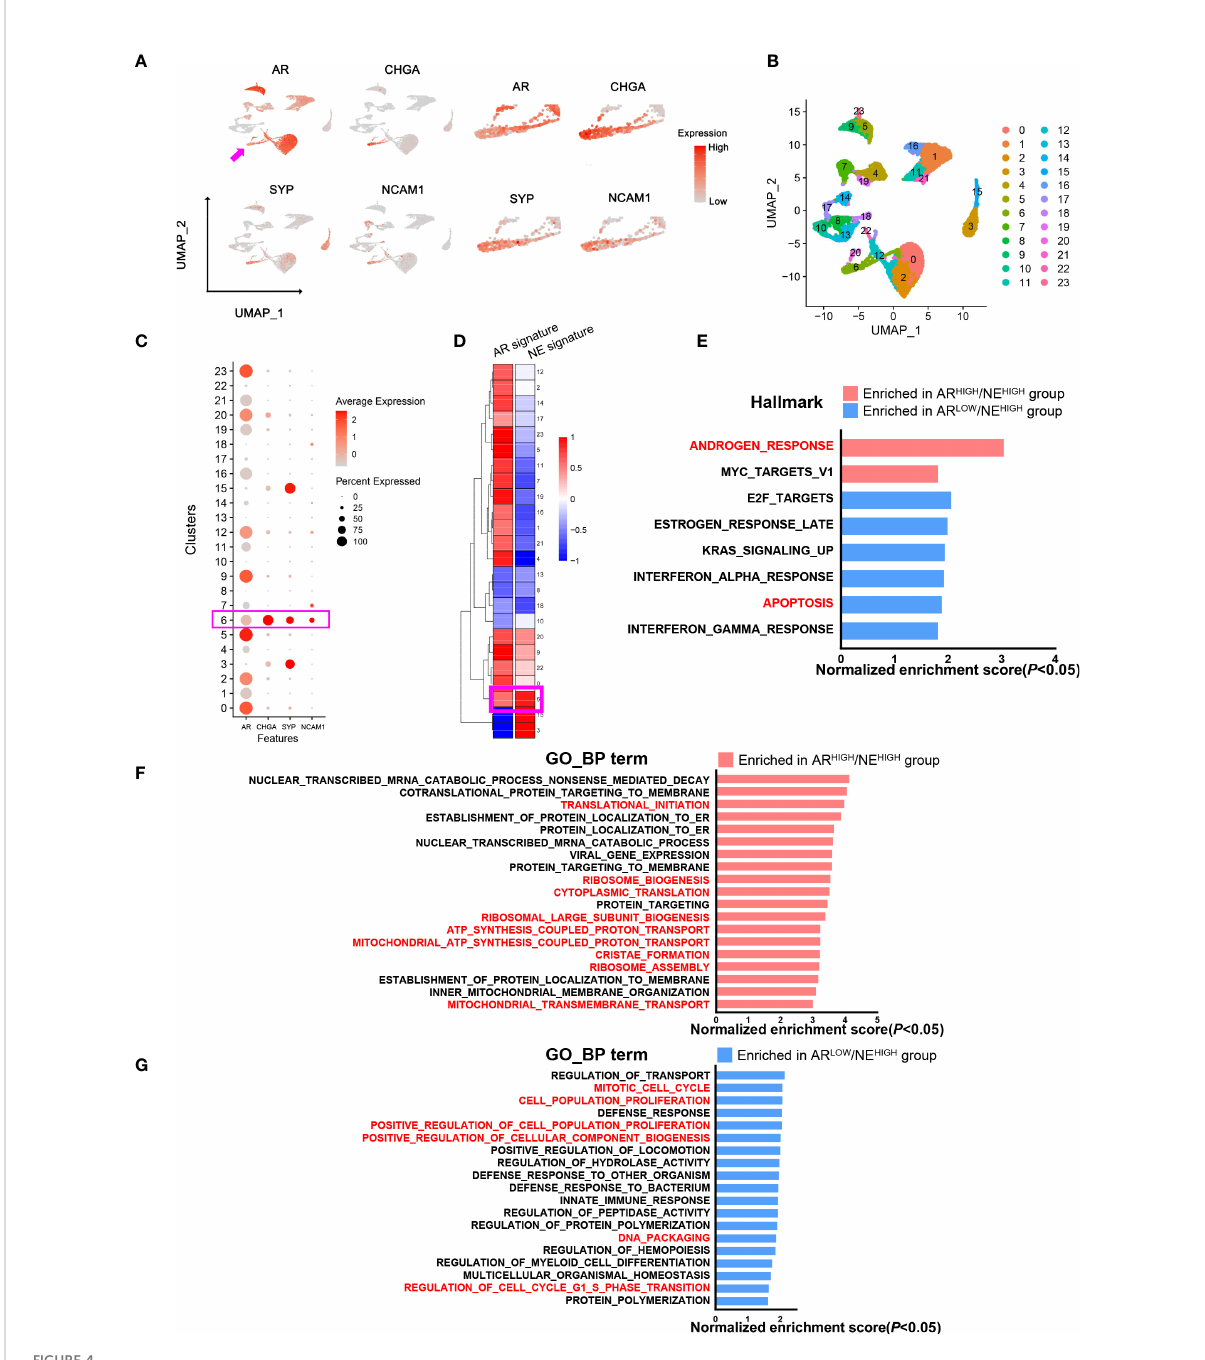
FIGURE 4 Comparative analysis of androgen receptor (AR)/neuroendocrine (NE)-associated genes in a single-cell transcriptome from prostate cancer patients. (A) Uniform Manifold Approximation and Projection plot showing an overlap of AR and NE marker expressions in prostate epithelial cells. (B) Uniform Manifold Approximation and Projection plot showing the cell clustering of prostate epithelial cells. (C) Dot plot showing the expression status of AR and NE markers in different cell clusters. (D) Heat map showing AR and NE signature scores in different cell clusters. (E) Pathway enrichment assessment of differentially expressed genes showing enriched Hallmark pathways in either AR HIGH /NE HIGH cells or AR LOW /NE HIGH cells ( P < 0.05; false discovery rate (FDR), <25%). (F) Pathway enrichment assessment of differentially expressed genes showing the top enriched Gene Ontology biological process pathways in AR HIGH /NE HIGH cells ( P < 0.05, FDR < 25%). (G) Pathway enrichment assessment of differentially expressed genes showing the top enriched Gene Ontology biological process pathways in AR LOW /NE HIGH cells ( P < 0.05, FDR <